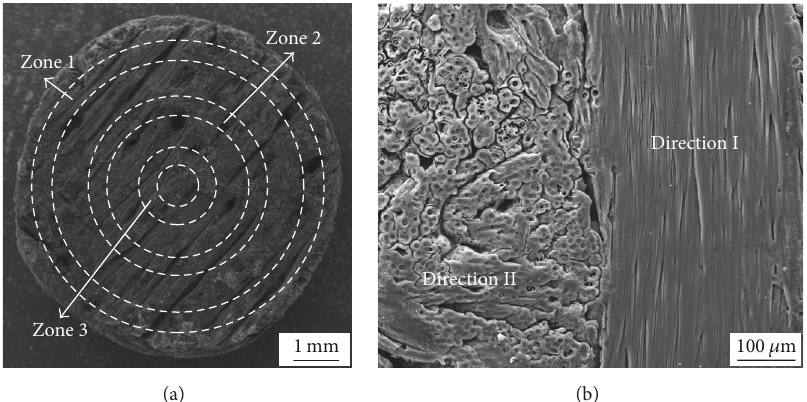
Figure 2: (a) SEM micrograph of C/C composite sample with increasing distance from the center (Zone 1: 3.5 mm ∼ 4.0mm, Zone 2: 2.5 mm ∼ 3.0 mm, and Zone 3: 0.5 mm ∼ 1.0mm); (b) SEM micrograph of C/C composites.